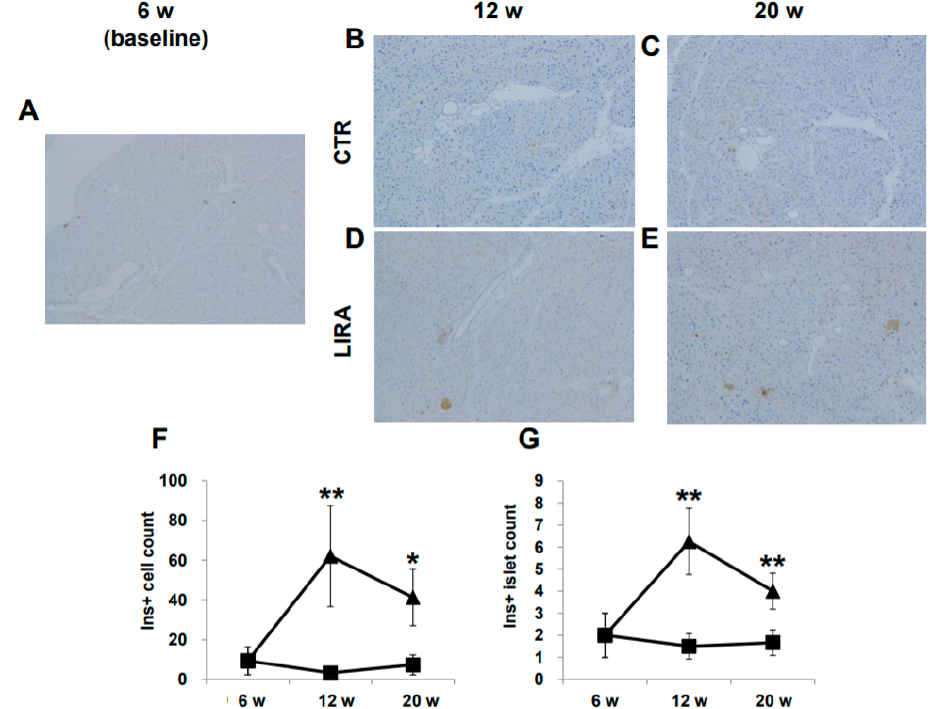
Figure 5. Histological images of the pancreas. Mice were euthanatized at 6 ( n = 4 for baseline), 12 ( n = 6/group), and 20 ( n = 6/group) weeks (w) of age. There were no anti-insulin antibody-stained cells at baseline ( A ), 12 w ( B ), and 20 w ( C ) in the control mice (CTR), whereas islets with insulin-positive (Ins+) cells were observed in the liraglutide-treated mice (LIRA) ( D , E ). The counts of Ins + cells ( F ) and islets with Ins+ cells ( G ) were compared between the groups. Data are presented as the mean, and error bars represent the standard deviation. Triangle: LIRA ( n = 4–6); square: CTR ( n = 4–6). * p < 0.05 and ** p < 0.01 vs. CTR.